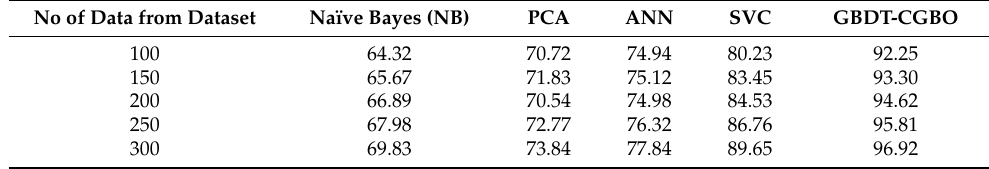
Table 2. Recall Analysis of GBDT-CGBO method with existing system in percentage.